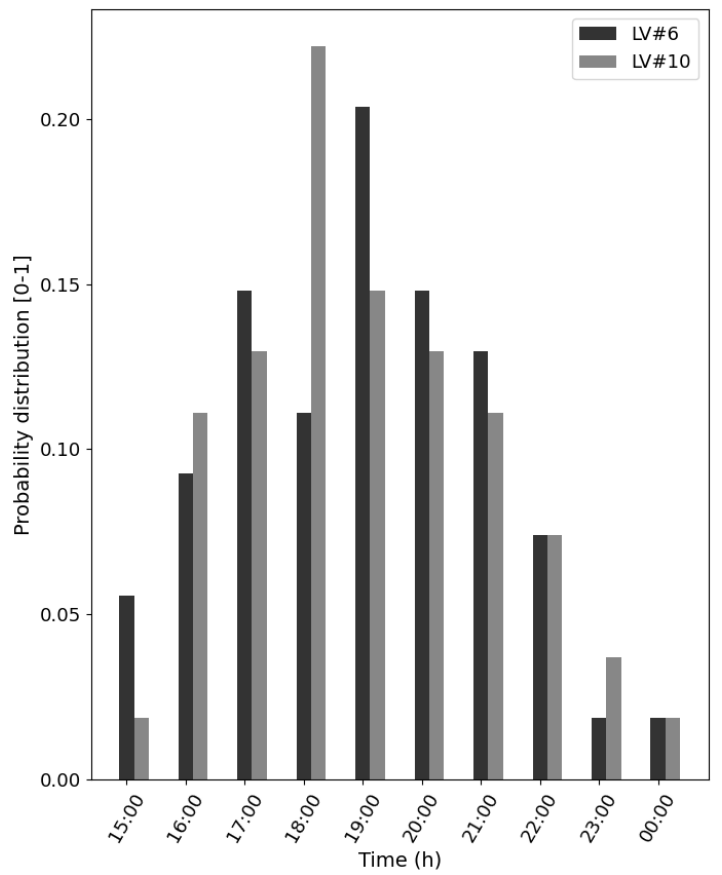
Figure 4. Probability distribution of EVs’ time of arrival.